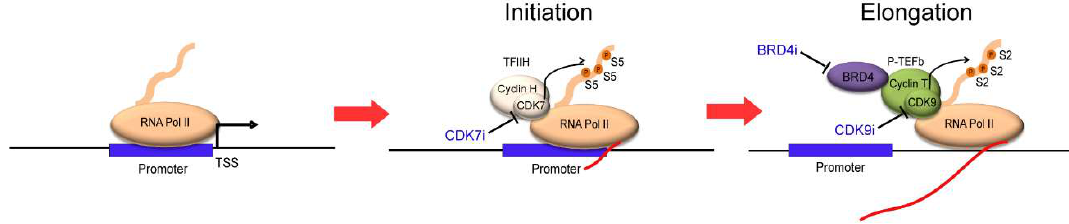
Figure 3. The CTD of RNA Pol II is first phosphorylated by the TFIIH complex (CDK7/Cyclin H) at serine 5 residue to initiate transcription. The P-TEFb complex (CDK9/Cyclin T) further phosphorylates RNA Pol II at serine 2 residue to facilitate transcriptional elongation. Small-molecule inhibitors of BRD4 (BRD4i), CDK7 (CDK7i), and CDK9 (CDK9i) block each of these processes.